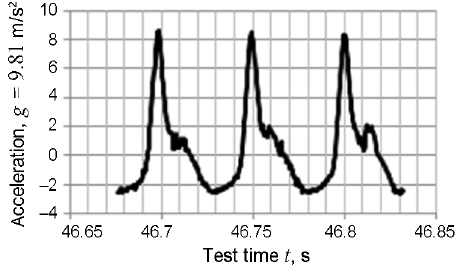
Fig. 2. Typical values of accelerations for the pile subjected to 20 Hz vibratory loads after the discontinuation of